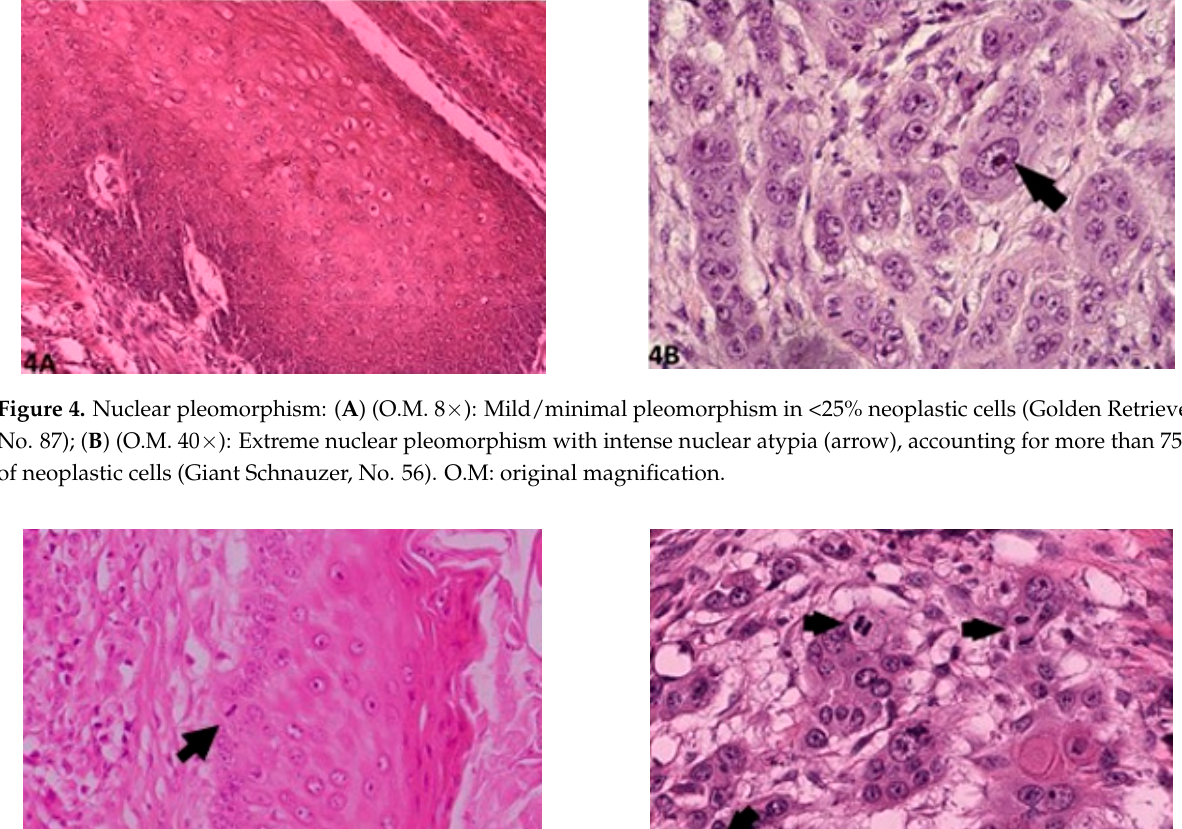
Figure 3. Host response: ( A ) (O.M. 8 × ): Marked inflammation, occasionally obliterating the neoplastic cells (Russian Terrier, No. 6); ( B ) (O.M. 8 × ): Minimal to virtually no associated inflammation (Rottweiler, No. 70). O.M: original magnification.